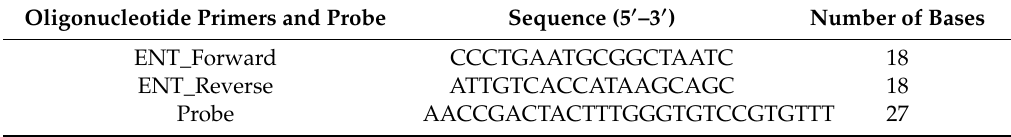
Table 2. The expression of Enteroviral RNA was calculated after normalization with beta-actin gene, which was used as an endogenous control (housekeeping gene). Table 2. Oligonucleotide Primers and Probe for Enteroviral RNA RT-qPCR. Oligonucleotide Primers and